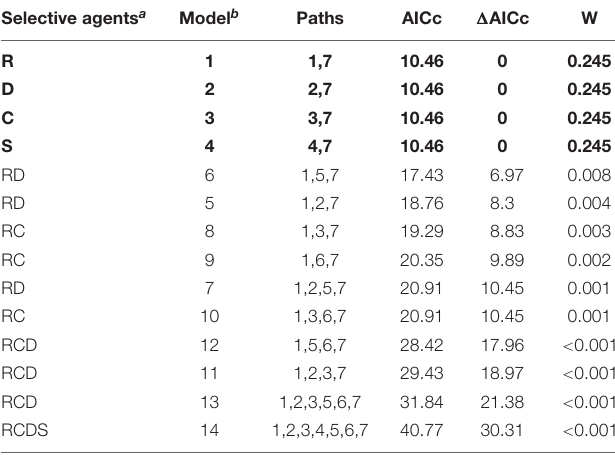
TABLE 6 | List of the a priori 14 candidate models of the effect of the four putative selective agents on embryo size with corresponding AICc values, (cid:49) AICc, and AICc weight